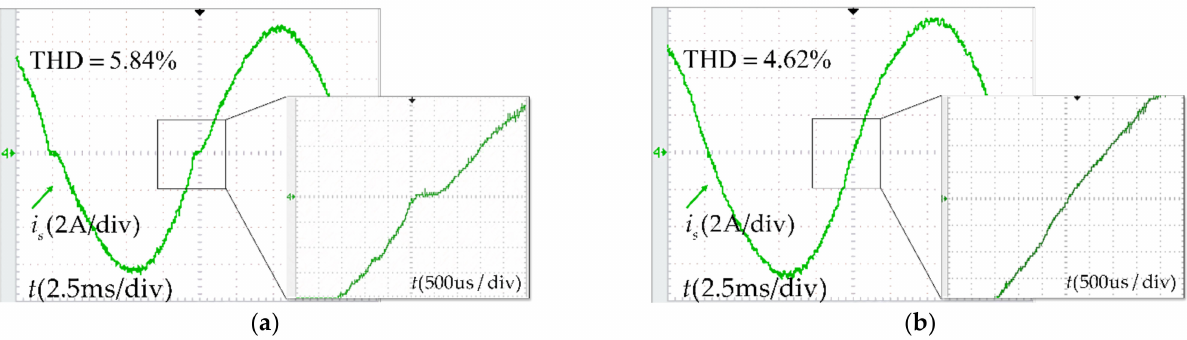
Figure 21. The current waveform when the dead time is 6 µ s. ( a ) No compensation ( b ) With